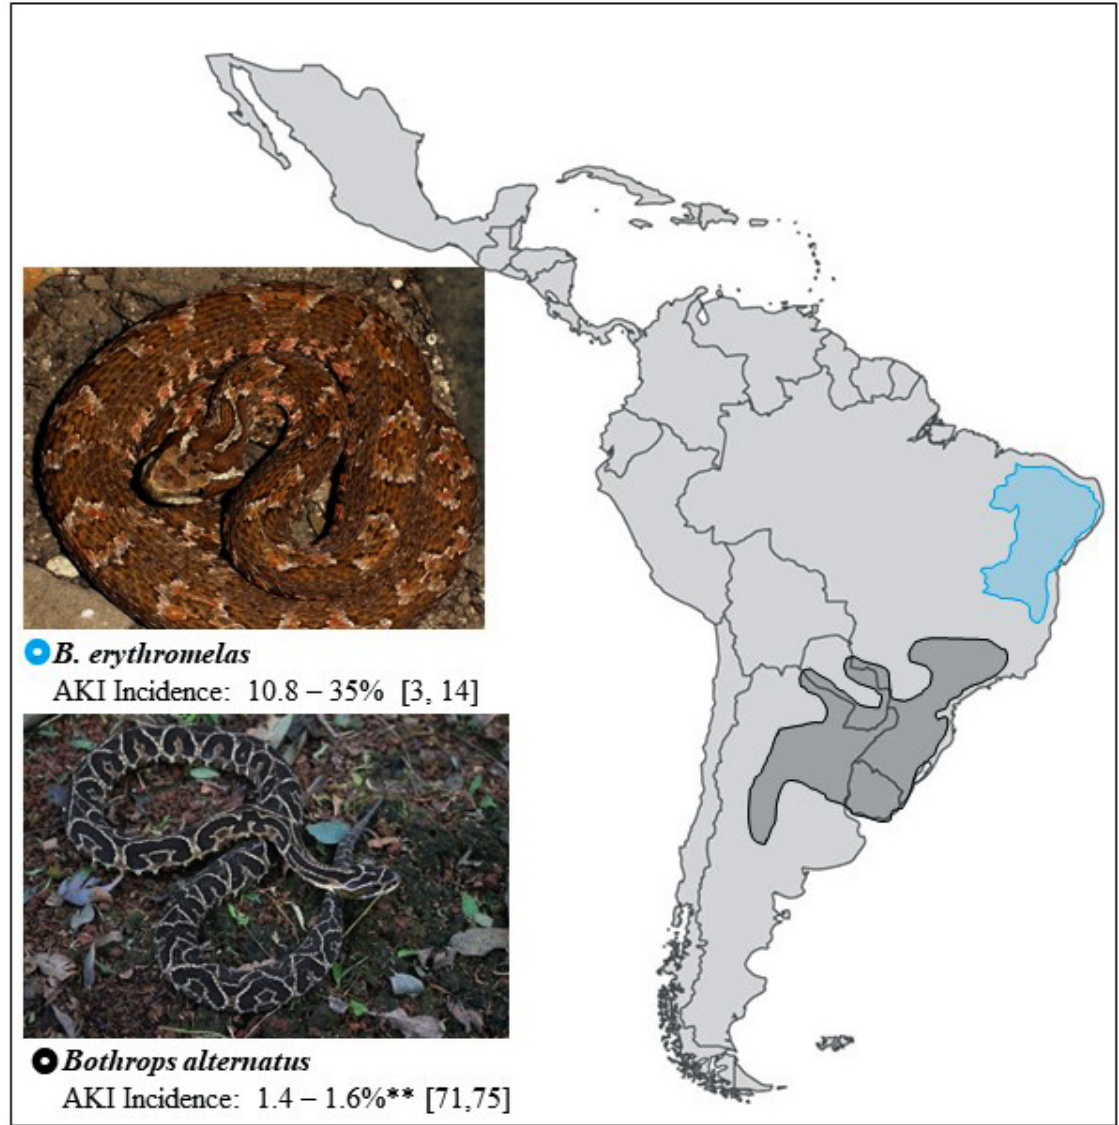
Figure 3. Geographical distribution of Bothrops erythromelas (photo courtesy of Bruno Cardi, Laboratory of Toxicology and Molecular Neuropharmacology, State University of Ceará, Brazil) and Bothrops alternatus (photo courtesy of Marcelo Duarte) and respective incidence of